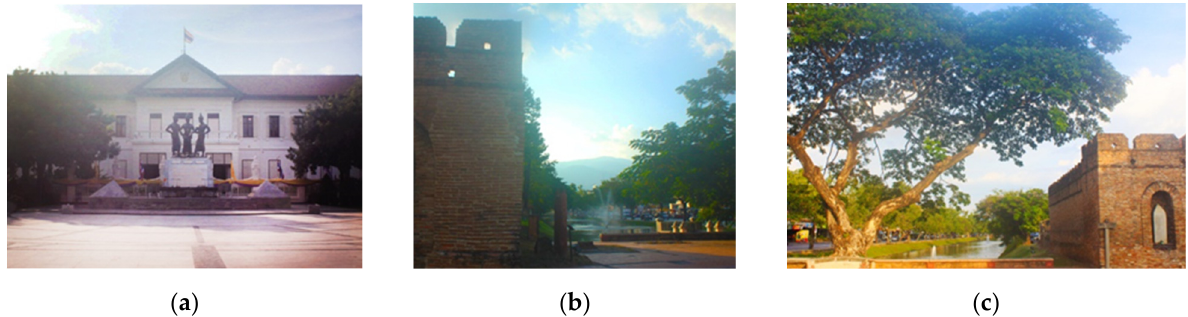
Figure 6. ( a ) Three Kings Monument Square (Author); ( b ) Chiang Mai City Moat (Author); ( c ) Chiang Mai City Moat (Author).